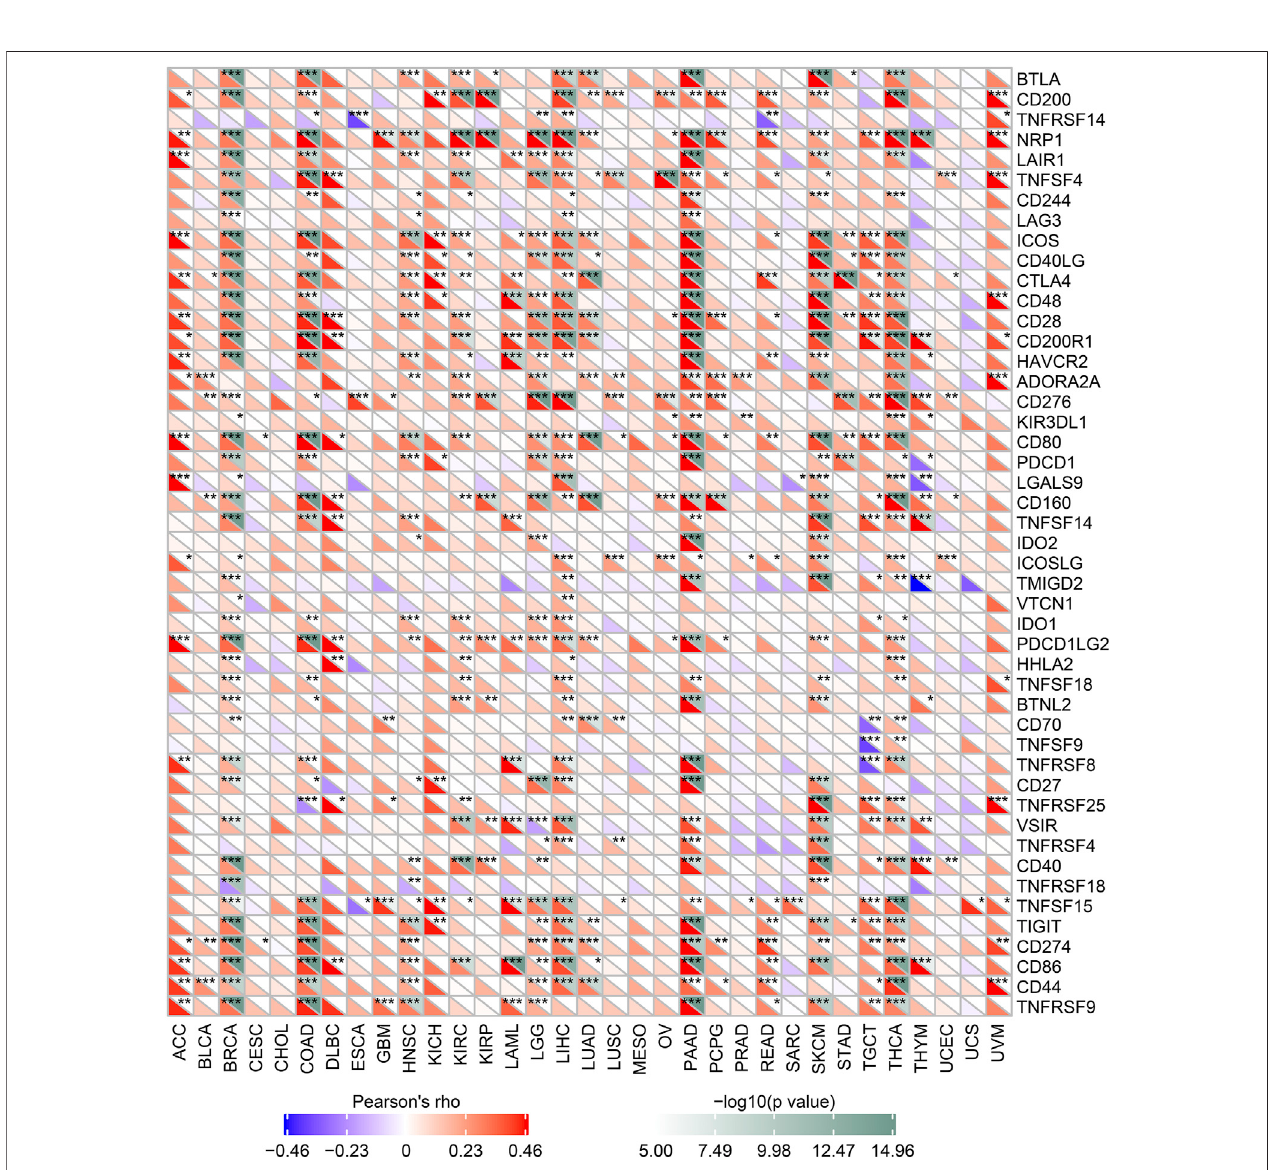
FIGURE 5 | each row and column represent one speci fi c gene and patient, respectively; (F) GOplot representation of the analysis of the gene ontology (GO) items enriched among the coexpressed genes. The left side of the circle displays the gene, and the right side shows the GO item. The assorted colors represent different GO items, and the color of each GO item is annotated below the circle. If the gene belongs to a GO item, there will be a line between the gene and the GO item. The z-score (bottom) shows log2 (gene foldchange).